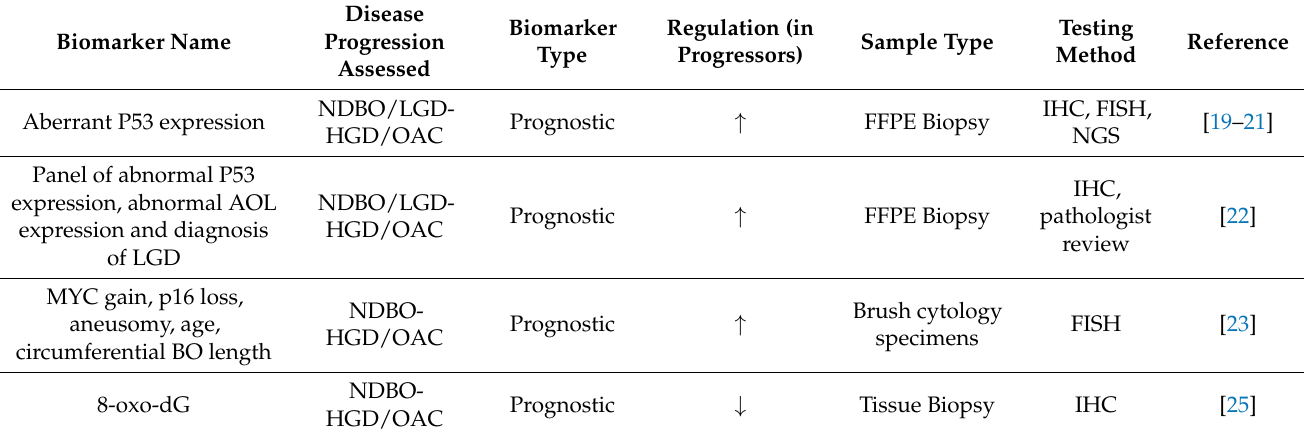
Table 1. Summary table of prognostic biomarkers for risk of progression with